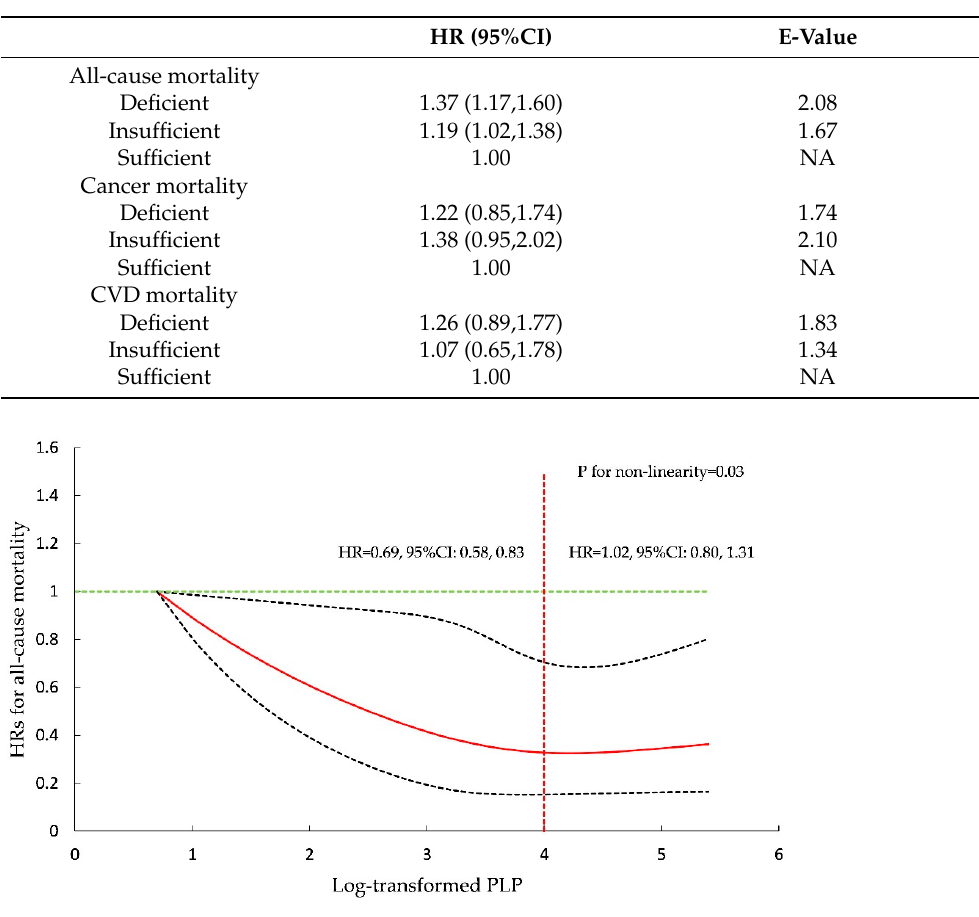
Model 1: adjusted for age (<60 years; ≥ 60 years) and sex (male; female). Model 2: further adjusted (from Model 1) for race/ethnicity (Hispanic; non-Hispanic white; non-Hispanic black; other non-Hispanic), marital status (married or living with partner; widowed, divorced, or separated; never married), education level (less than high school; high school or equivalent; college or above), family income/poverty ratio (0–1.0; 1.1–3.0; >3.0). Model 3: further adjusted (from Model 2) for BMI (normal weight or underweight [<25 kg/m 2 ]; pre-obese [25–29.9 kg/m 2 ]; obese [ ≥ 30 kg/m 2 ]), smoking status (never smoker; former smoker; current smoker), drinking status (never drinker; former drinker; current drinker), physical activity level (<150 min MVPA/week; ≥ 150 min MVPA/week). Table 3. E-values for the point estimates.